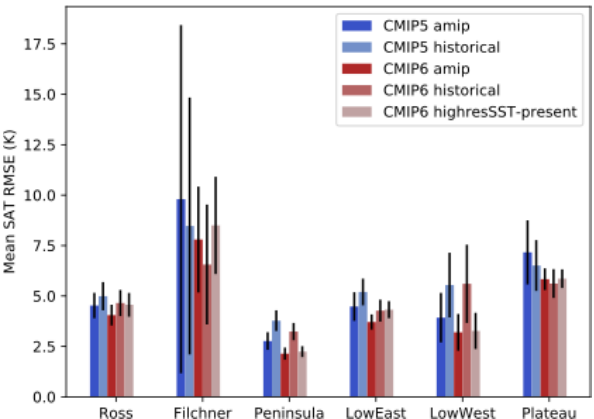
Figure E1. Multi-model mean of the multi-station mean root-mean- square error (RMSE, in kelvin) of simulated monthly surface air temperatures against SCAR READER stations (AWS and manned), for the different regions. The regional mean inter-model standard deviation is shown as black error bars, indicating, for some re- gions, reduced inter-model spread in CMIP6 compared to CMIP5 and modest overall